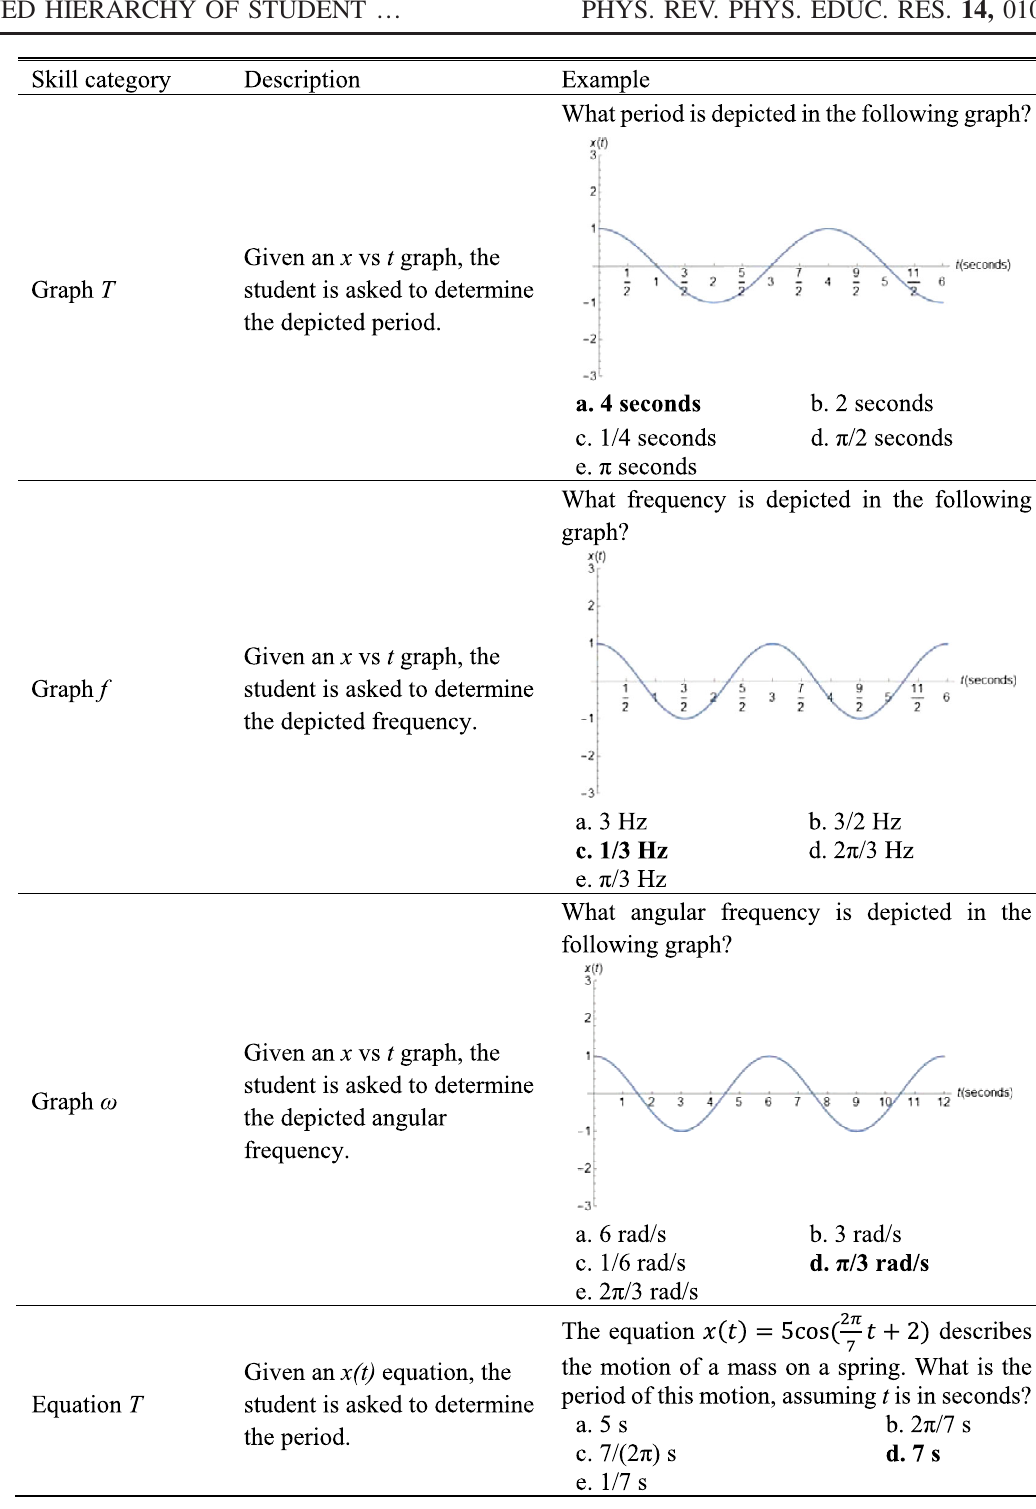
FIG. 1. The nine skill categories needed to determine the period, frequency, and angular frequency from graphical and mathematical